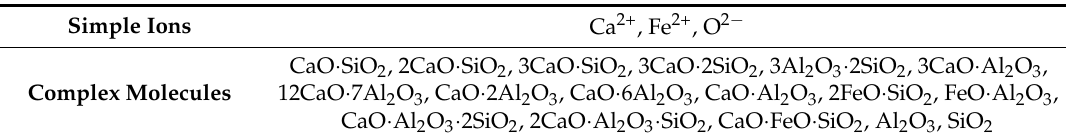
Table 1. Structural units in the slag